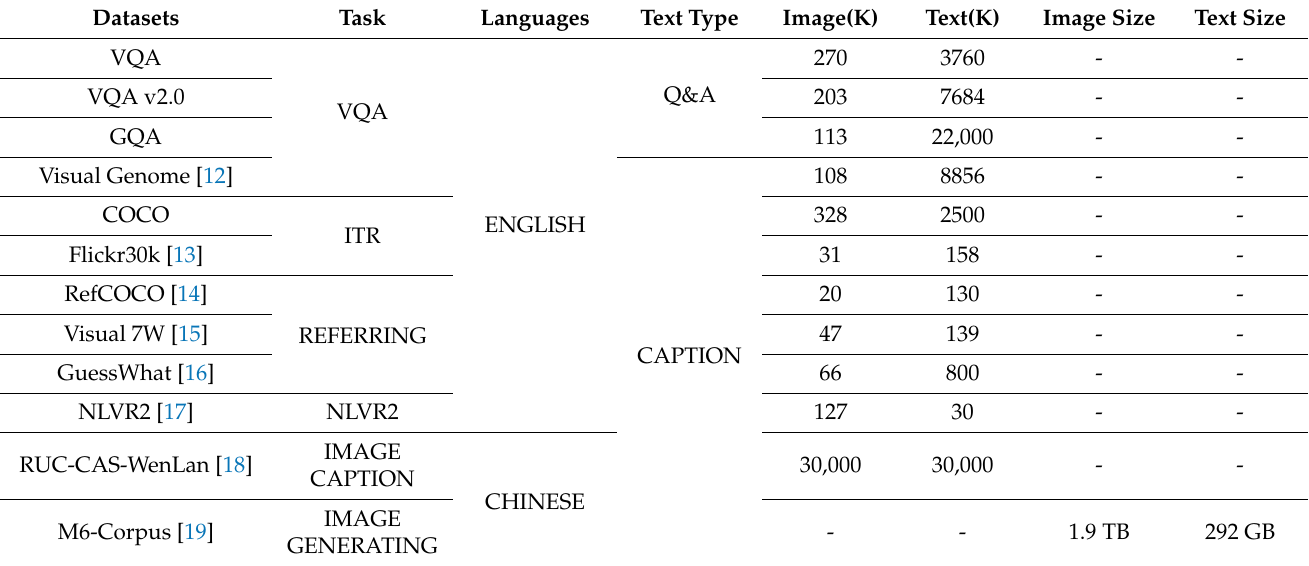
Table 2. Common datasets for image–language